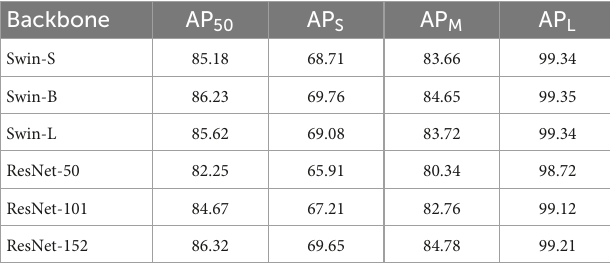
TABLE 3 Comparisons between different